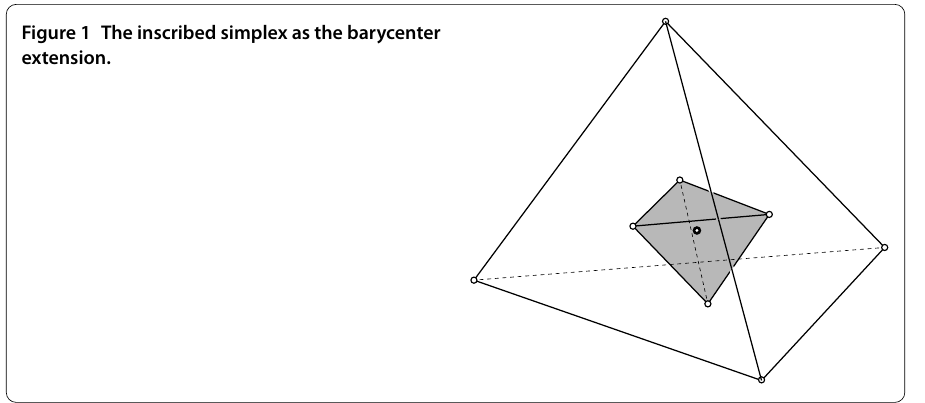
Figure 1 The inscribed simplex as the barycenter